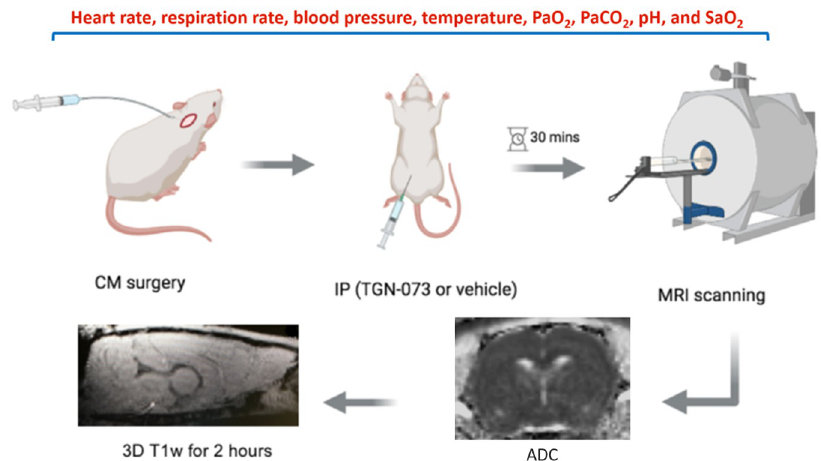
Fig 1. Study design (protocol). Cisterna magna cannulation then intraperitoneal injection of the drug; wait half an hour and start MRI scanning. CM: cisterna magna, IP: intraperitoneal, ADC: apparent diffusion coefficient, and MRI: magnetic resonance imaging.